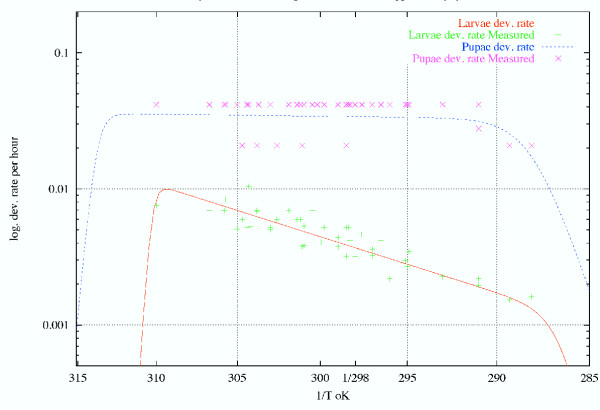
Larvae and pupae development rates.